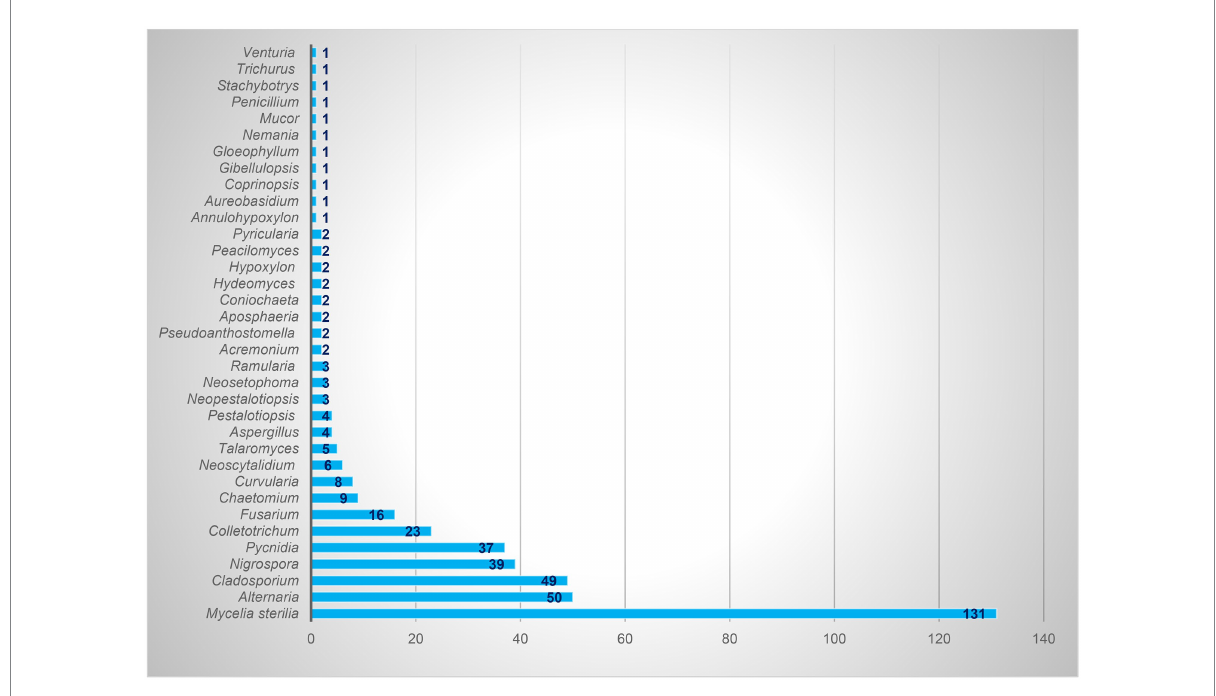
FIGURE 3 Total isolates of each identified endophytic genus.